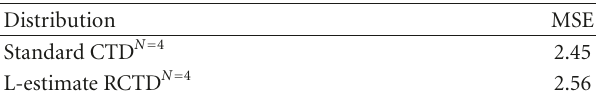
Table 2: The MSE of instantaneous frequency estimation in the presence of Gaussian